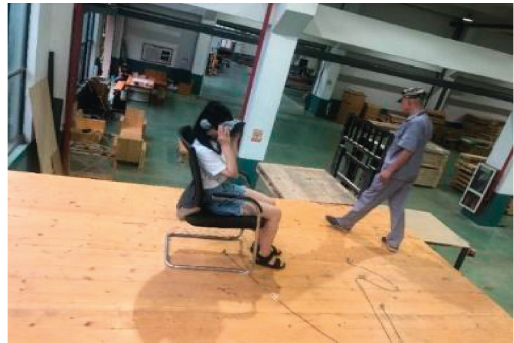
Figure 5: The test subject and the walking/running tester.